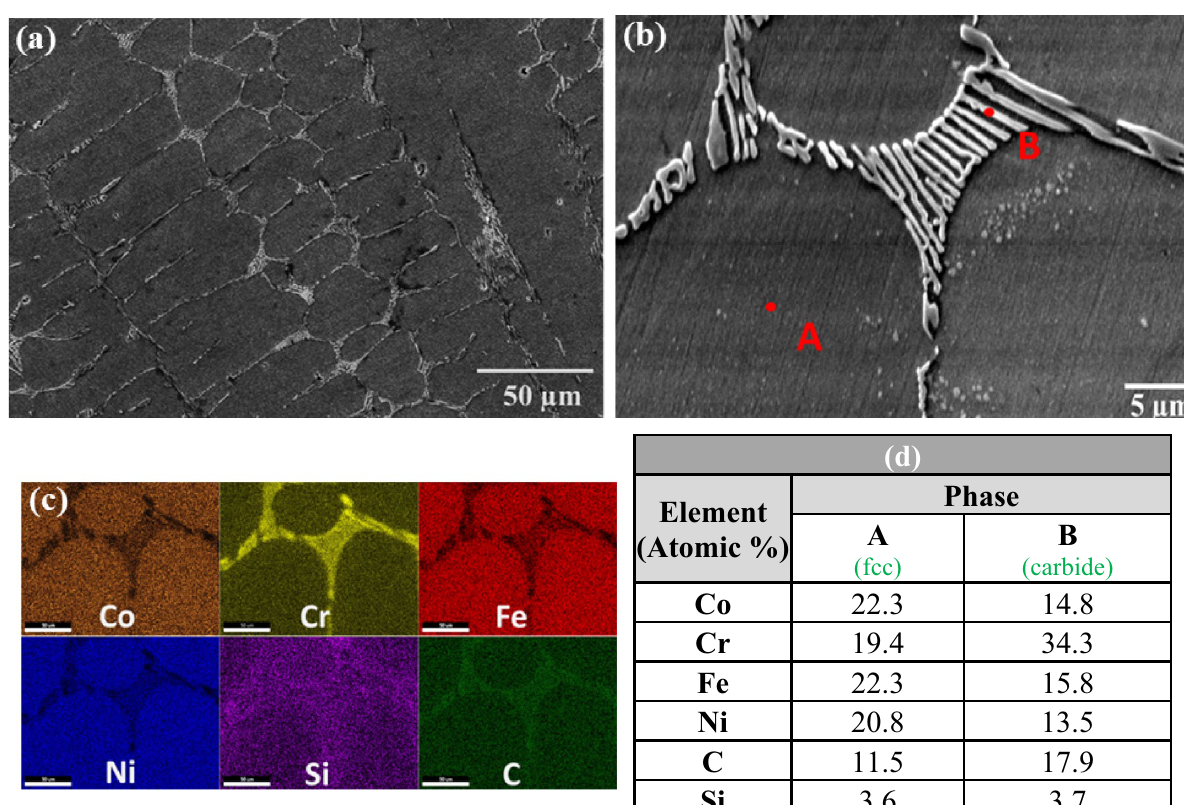
Figure 2. ( a ) SEM image of sample S-1, ( b ) magnified view, ( c ) elemental mapping, ( d ) EDS results at the indicated